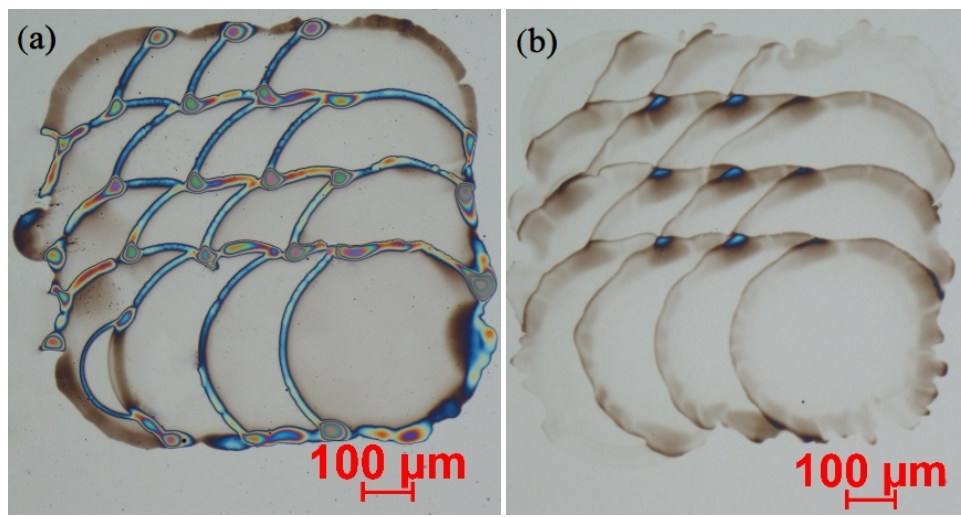
Figure 5. Comparison of inkjet-printed dots from differently thinned PEI solutions: ( a ) PEI dots printed from 1% w / v solution; ( b ) PEI dots printed from 0.3% w / v solution.